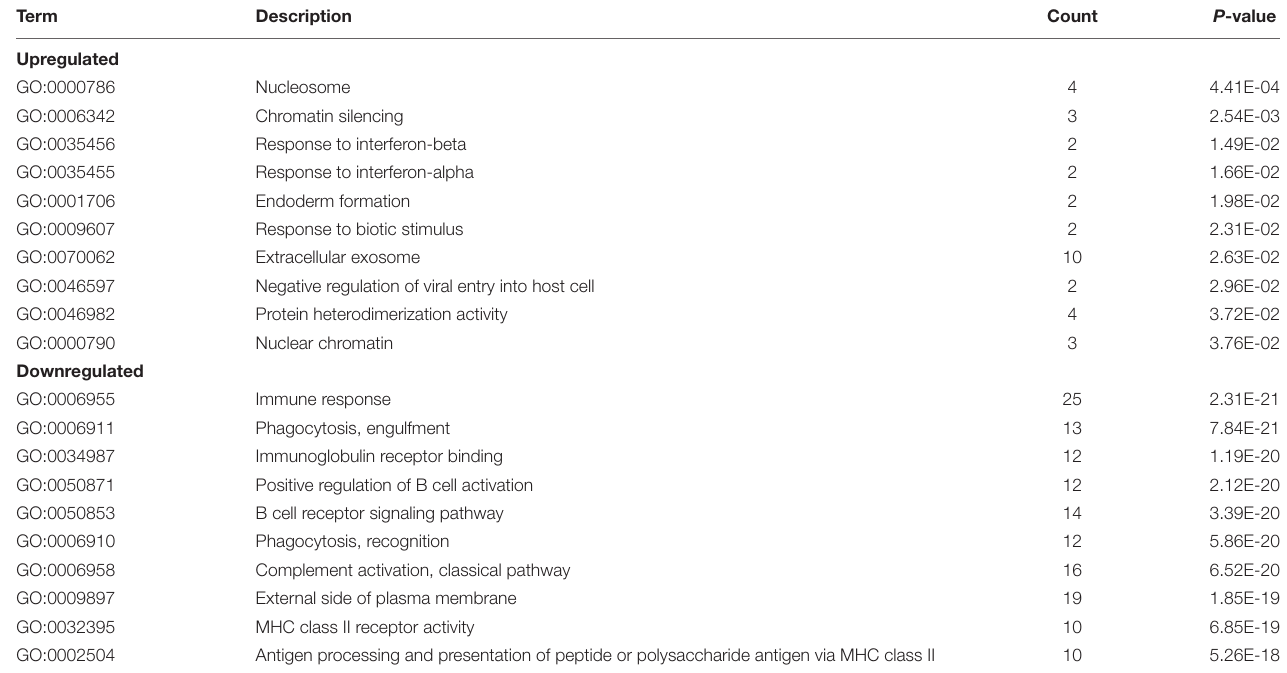
TABLE 1 | Gene Ontology term enrichment analysis of DEGs in multiple myeloma. Term